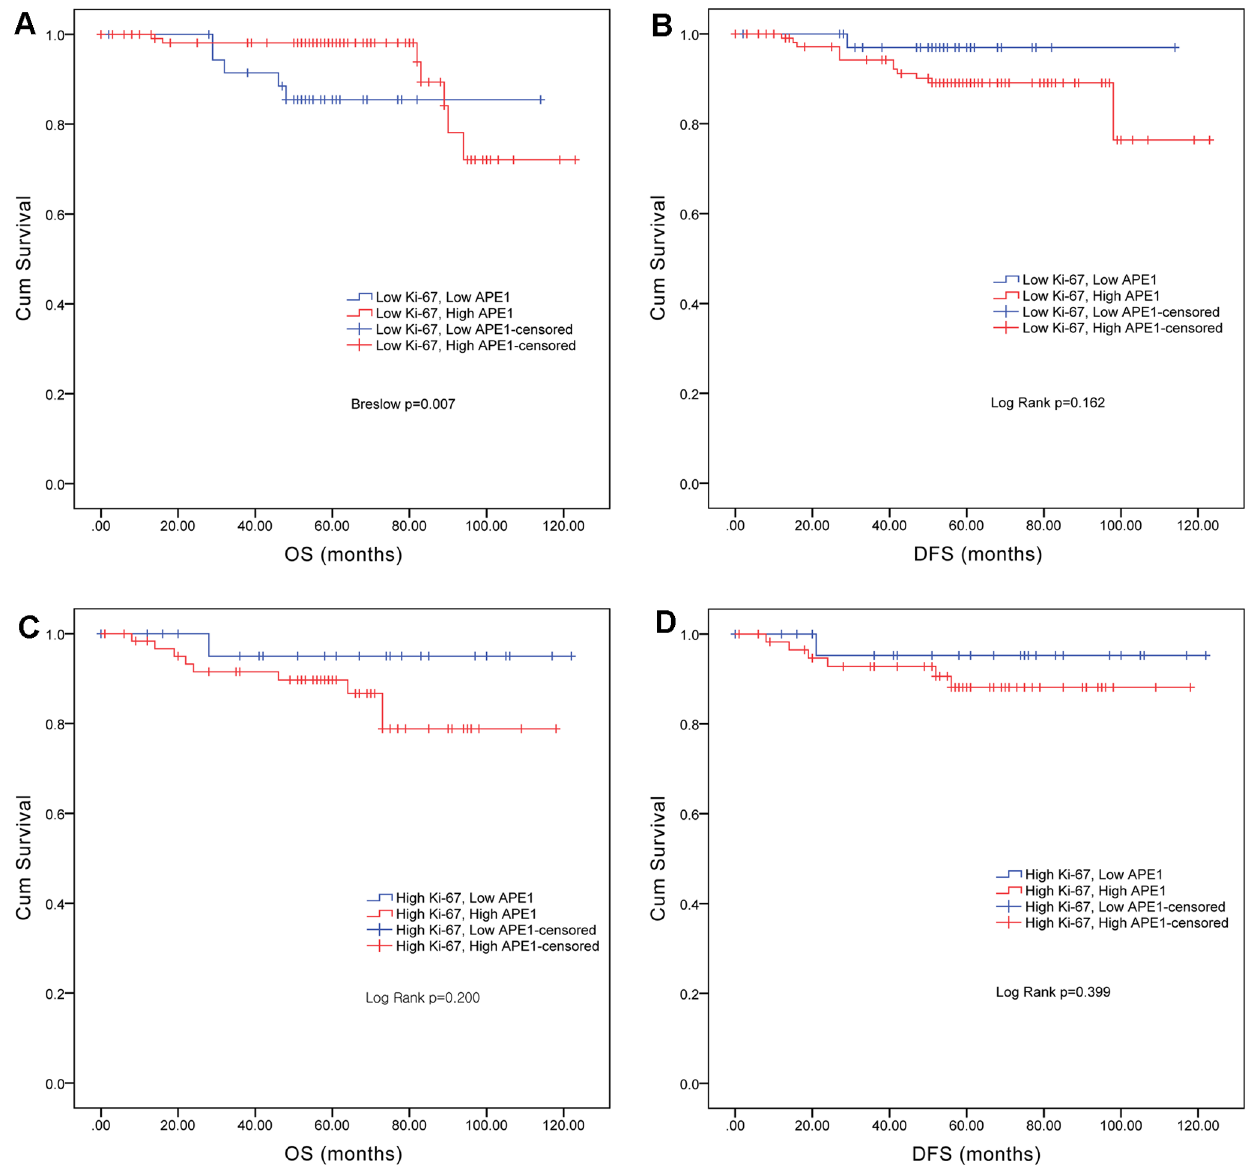
Figure 3. Kaplan-Meier survival curves based on APE1 expression levels in Ki-67-stratified cohorts. A . OS in the Ki-67 low-level expression cohort. B . DFS in the Ki-67 low-level expression cohort. C . OS in the Ki-67 high-level expression cohort. D . DFS in the Ki-67 low-level expression cohort. Within the Ki-67 low-level expression group, APE1 low-level expression was associated with poor OS and within the Ki-67 high- level expression group, APE1 low-level expression was associated with good OS. (High APE1 ( red ), Low APE1 ( blue ).)